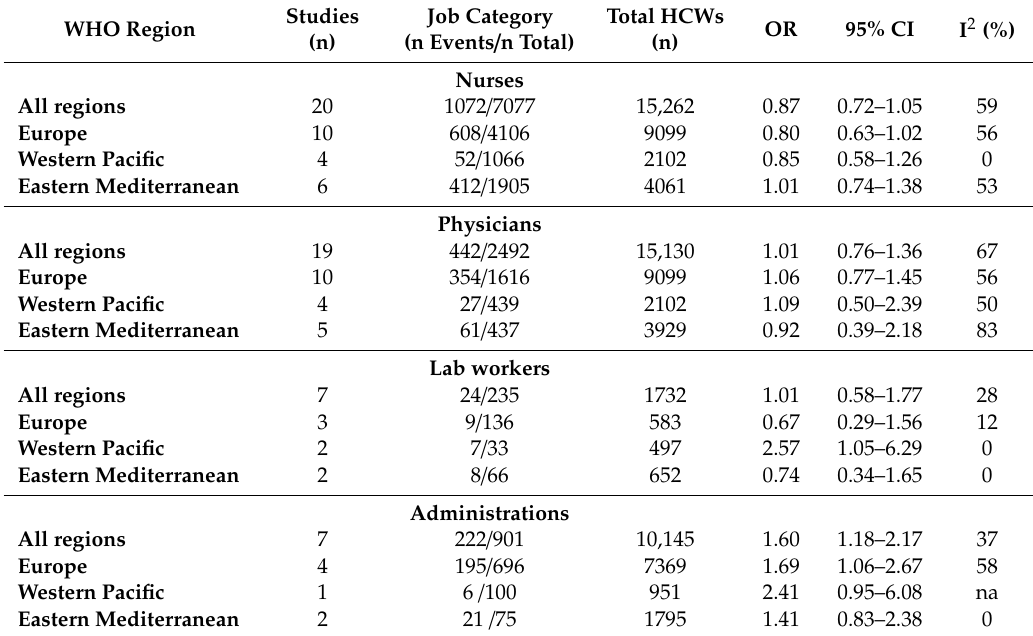
Table 3. Meta-analysis for job categories by WHO